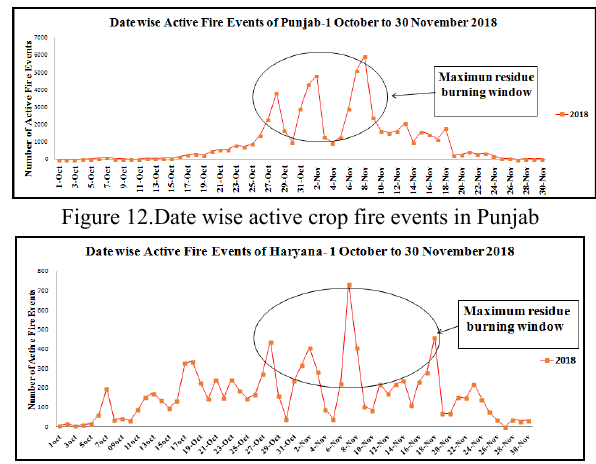
Figure 13. Date wise active crop fire events in Haryana